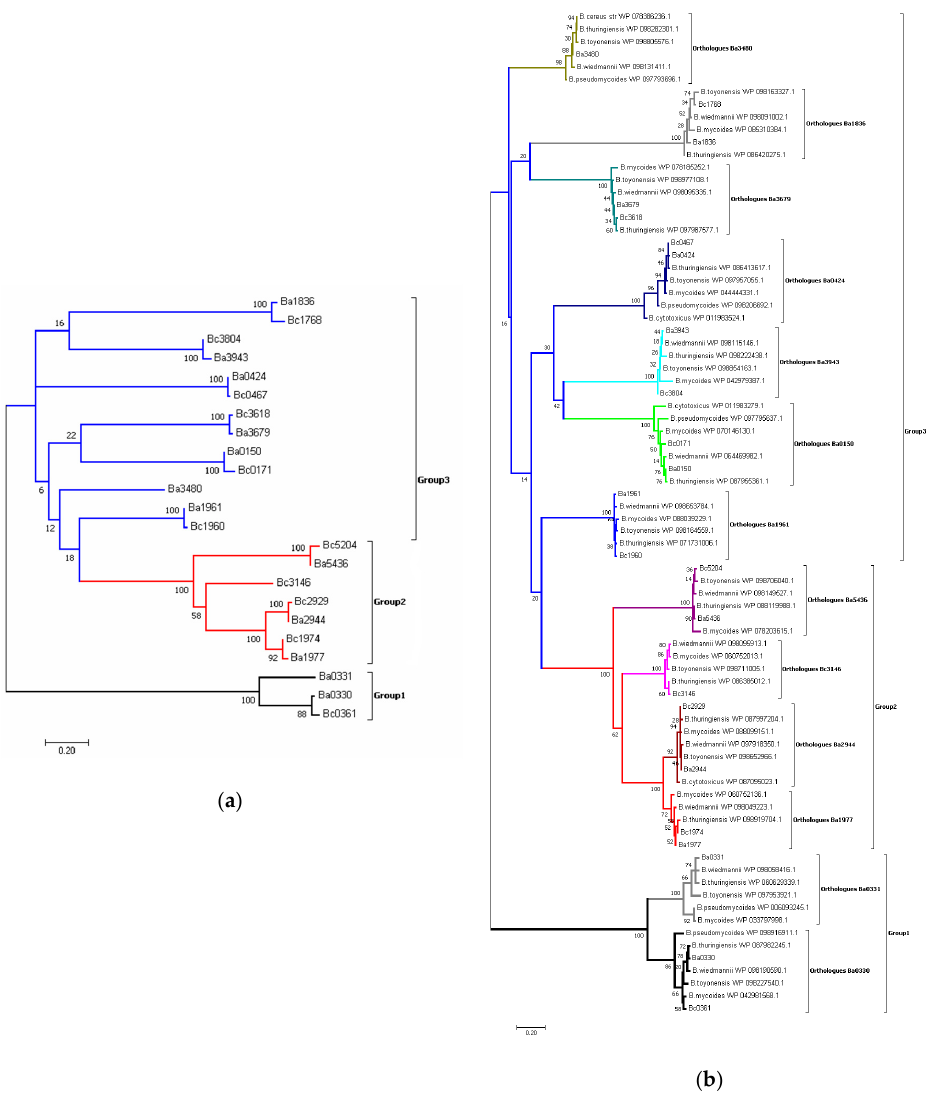
Figure 2. Molecular phylogenetic analysis of the PDA NodB domain. ( a ). The unrooted tree of 23 protein sequences of the PDA NodB domain from B. anthracis strain Ames (Ba) and B. cereus strain ATCC14579 (Bc) by the Maximum Likelihood method and with the highest log likelihood ( − 4084.19) is shown. The sequences are clustered in three groups represented with different colours (Group 1 in black, Group 2 in red and Group 3 in blue). ( b ). The unrooted tree of the NodB domain of 80 PDA amino acid sequences (homologues of the B. anthracis strain Ames (Ba) and B. cereus strain ATCC14579 (Bc) given in Figure 1a), selected from six different Bacilii species by the Maximum Likelihood method and with the highest log likelihood ( − 5578.53) is shown. The percentage of trees where the associated taxa clustered together is shown next to the branches. Grouping of the orthologues with respect to the B. anthracis / B. cereus species is shown in different